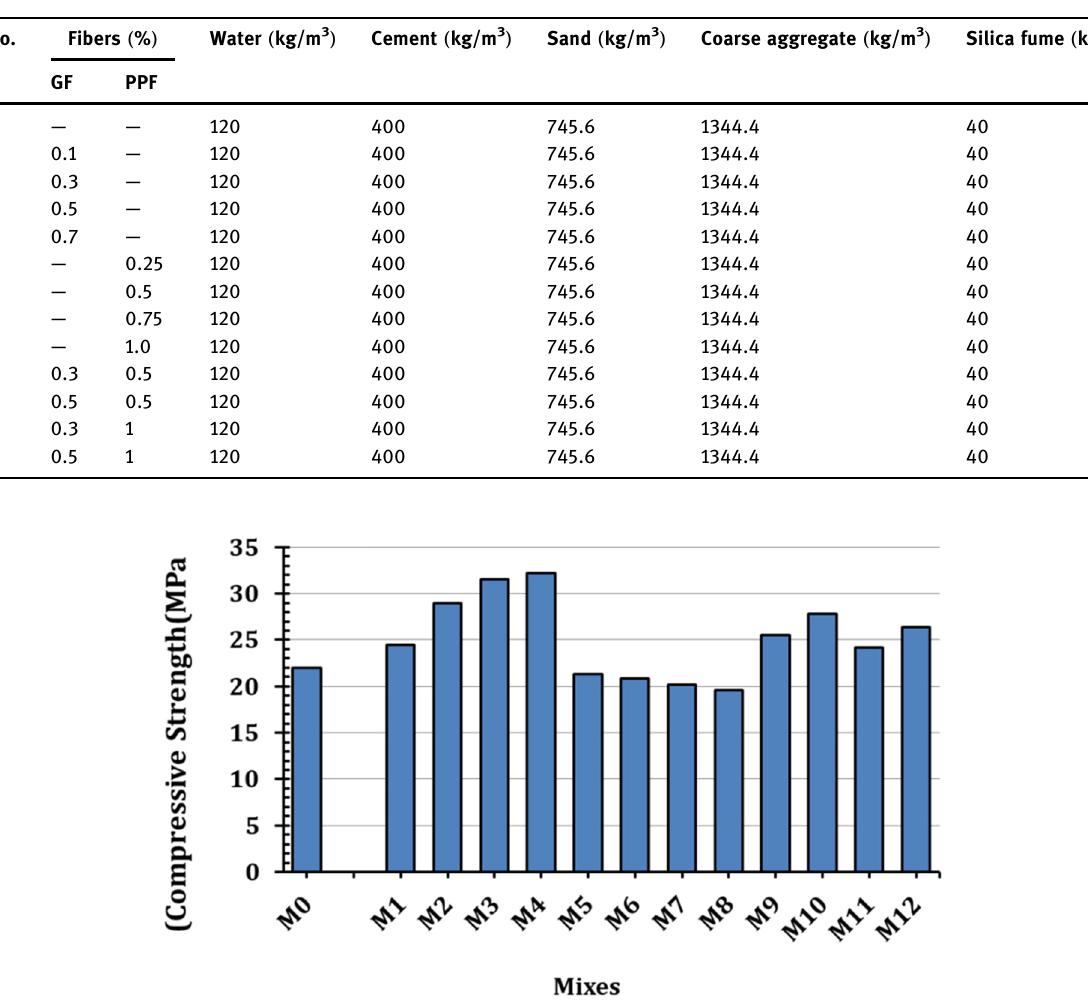
Table 10: Mix proportion of HSC mixes